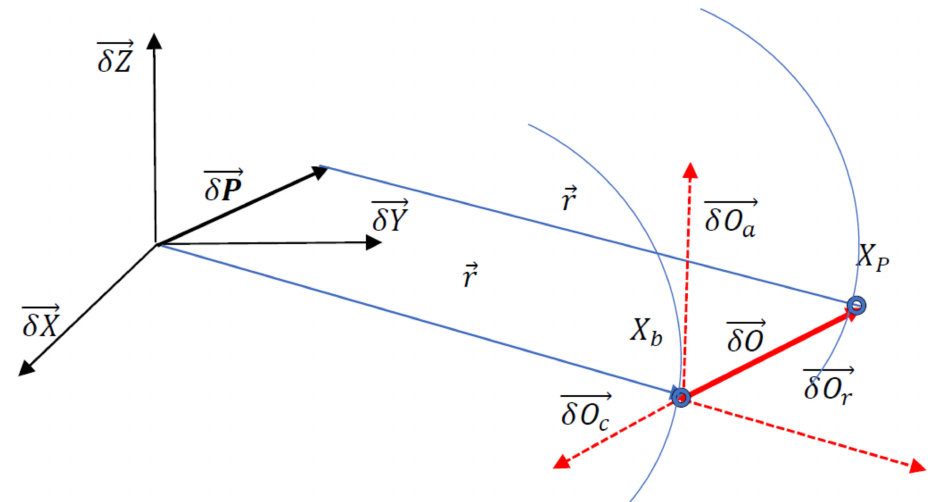
Figure 1. The interpretation of space-state representation (SSR) orbit